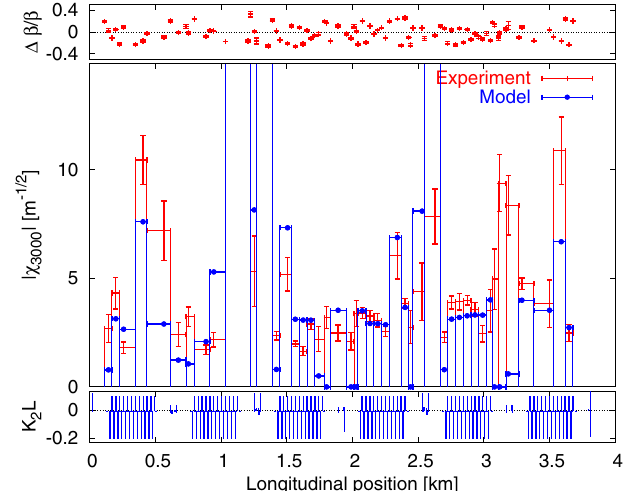
j from kick data. The top 3000 j 3000